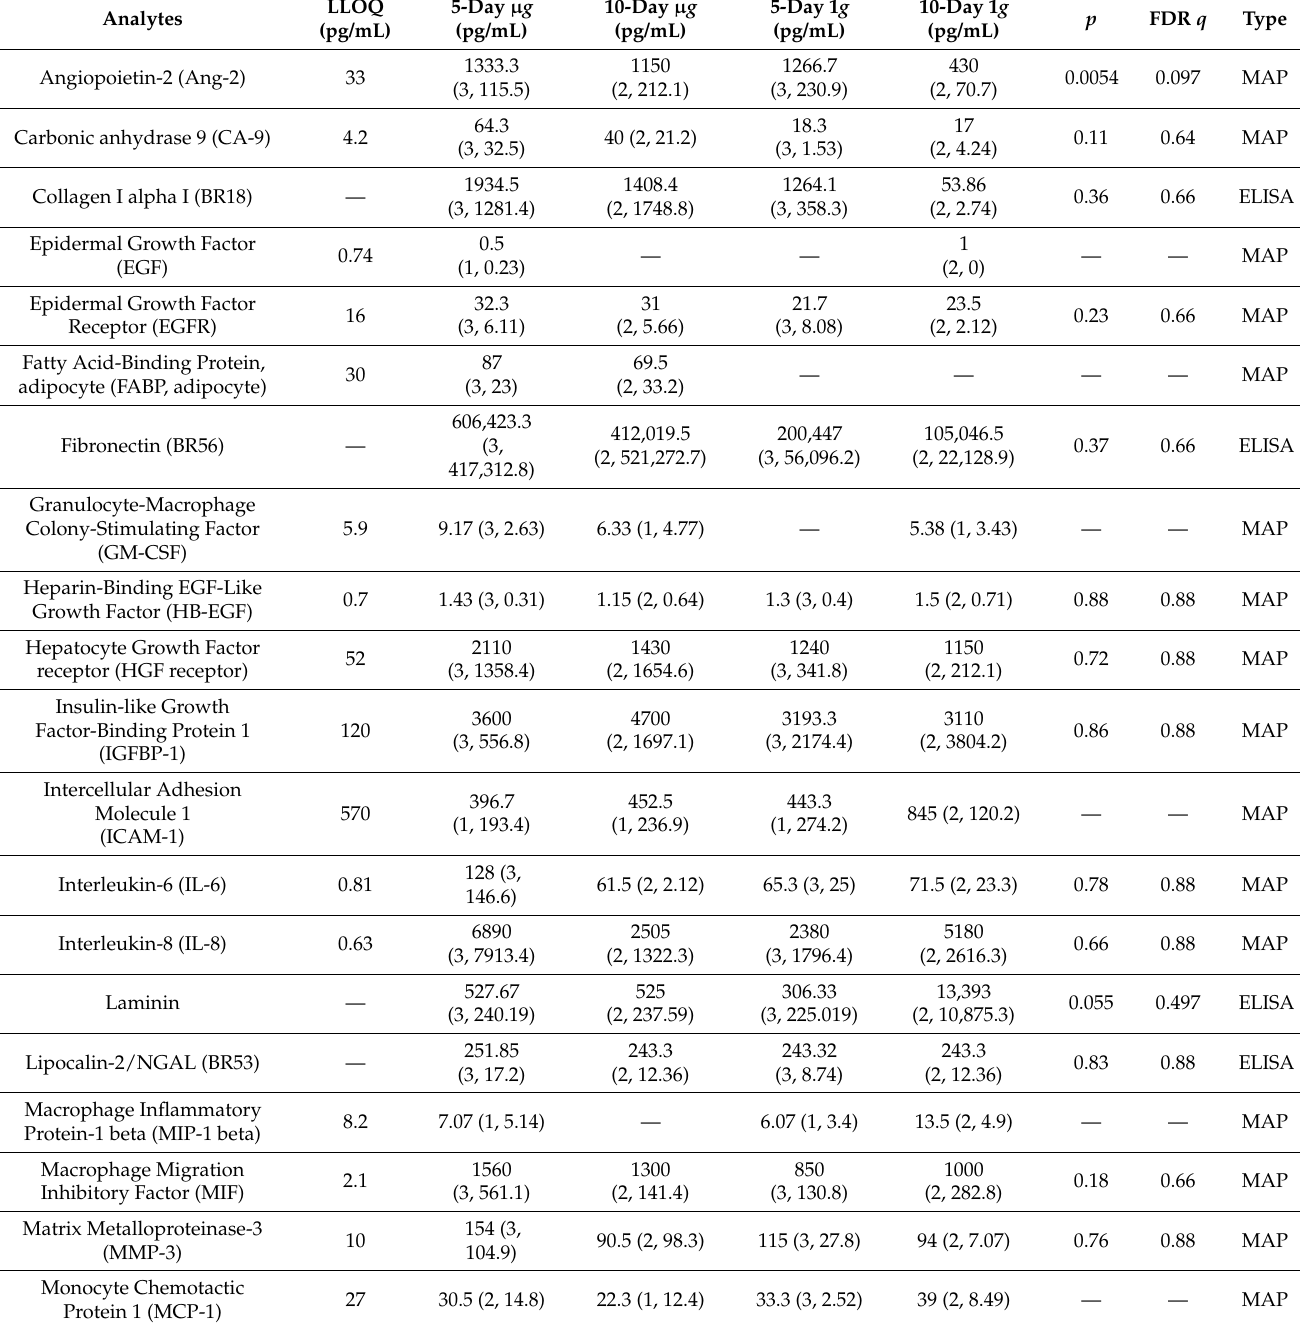
Table 1. Overview of soluble factors secreted by FTC-133 cells during spaceflight and in ground controls. Analyte levels were determined using Myriad RBM Human AngiogenesisMAP ® v. 1.0 (Type = multianalyte profiling (MAP)) or enzyme- linked immunosorbent assay (ELISA) kits from LifeSpan BioSciences (Type = ELISA). For each analyte and condition, the mean is presented, with the Myriad RBM samples with analytes below the lower limit of quantitation (LLOQ) assumed as LLOQ/2. The number of samples above the LLOQ and the standard deviations are given in round brackets. Analytes with no measured value above the LLOQ for a specific condition are marked with “—”. Analysis of variance p -values and false discovery rate (FDR) q -values are listed for complete